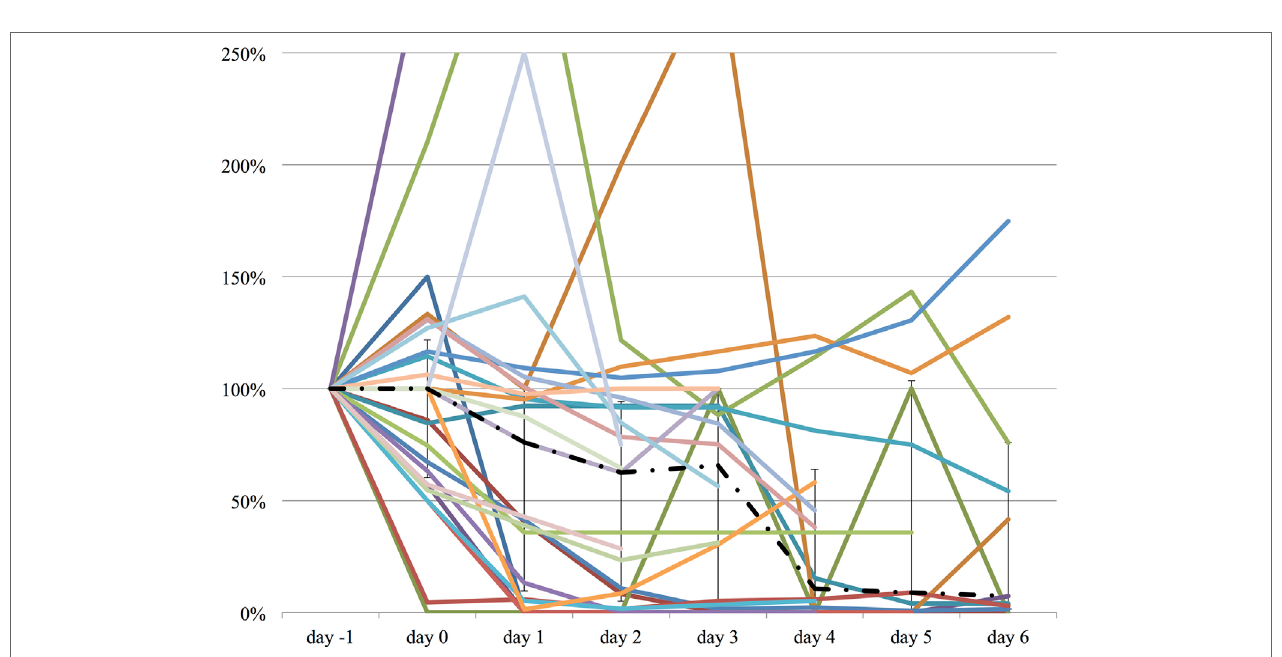
FigUrE 3 | The relative change in fentanyl equivalent dose from day − 1 to day 6 . The vertical axis represents percent change of fentanyl equivalent of each patient, compared to day − 1. The dashed line represents the median fentanyl equivalent dose, and the range represents the interquartile range.